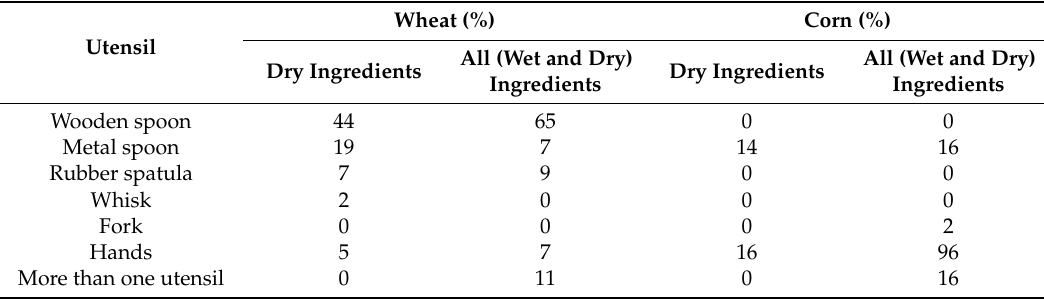
Table 6. Utensils used by 43 wheat dough preparers and 50 corn dough preparers in each of the mixing stages during the dough preparation sessions.